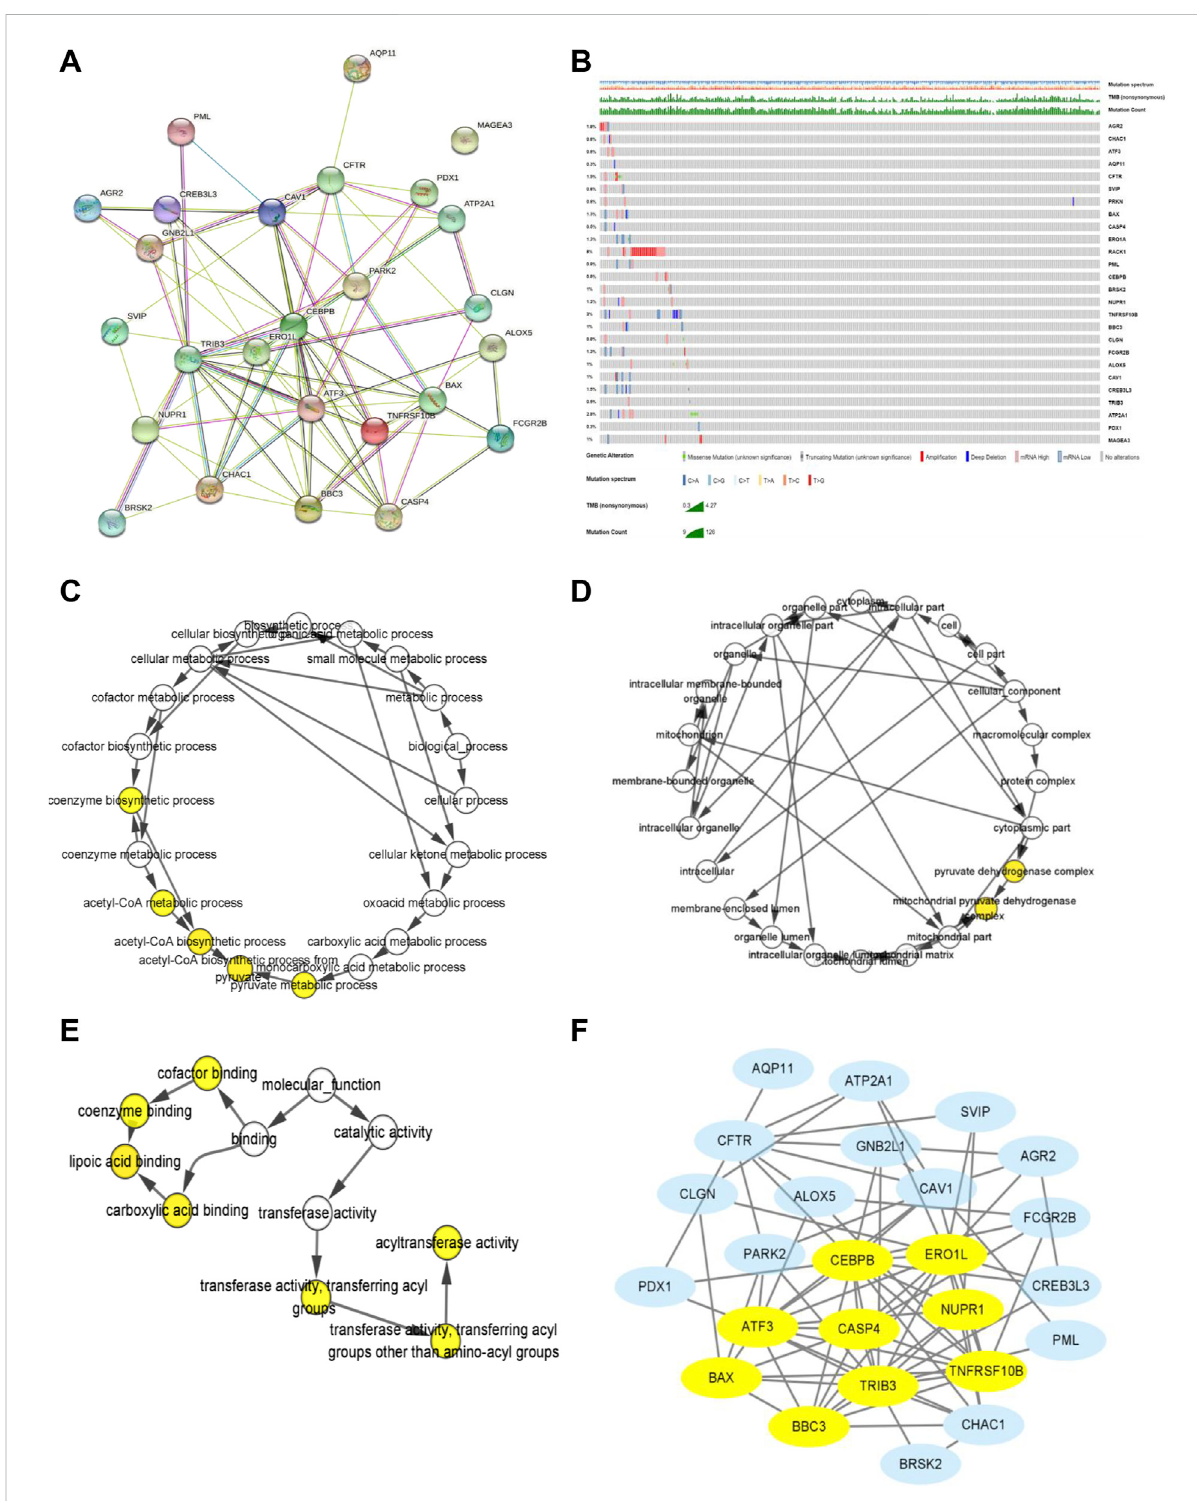
FIGURE 4 BiologicalfunctionandgeneticmutationlandscapeofERstress-relatedDEGsinKIRC. (A) PPInetworkacquiredfromtheSTRINGwebsiteofER stress-relatedDEGs. (B) Main types ofgenetic mutations of ERstress-relatedDEGs. (C – E) Biological processes,cellular components,and molecular functions ofERstress-relatedDEGs. (F) Relationshipamongtheproteinexpressionof26 ERstress-relatedDEGsbyusingtheMCODE plugin.Yellow means hub